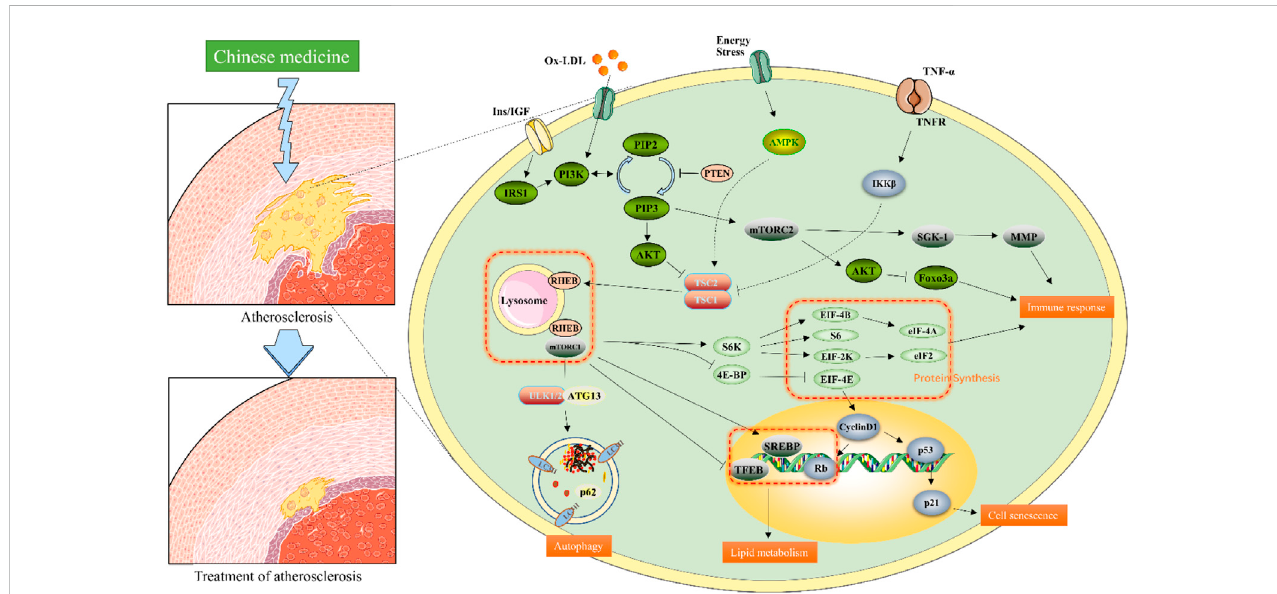
FIGURE 3 MolecularmechanismofthemTORsignalingpathwayassociatedwithAS.Whenthesiteofatherosclerosisoccurs,TNF- α ,lipiddeposition,andincreased nutrients activate the mTOR signaling pathway. These signal transductions converge on TSC1/2, which in turn inhibits Rheb activity. Rheb regulates mTORC1 activity by modulating conception. mTOR2 is mainly regulated by PI3K/AKT signaling pathway. mTORC1 and mTORC2 work together to regulate downstreamproteins.TheapplicationofnaturalcompoundsfrombotanicaldrugsaffectstheactivityoffactorsrelatedtothemTORsignalingpathwayin different ways, thereby increasing autophagy, inhibiting in fl ammation, delaying aging, and regulating lipid